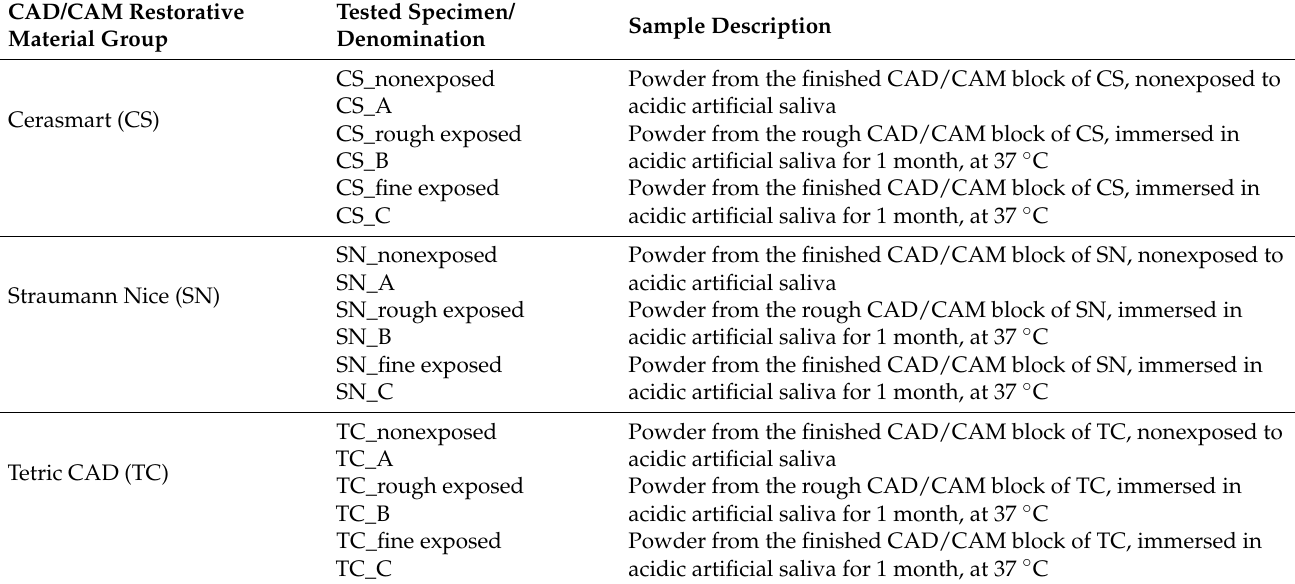
Table 2. The CAD/CAM restorative materials tested in